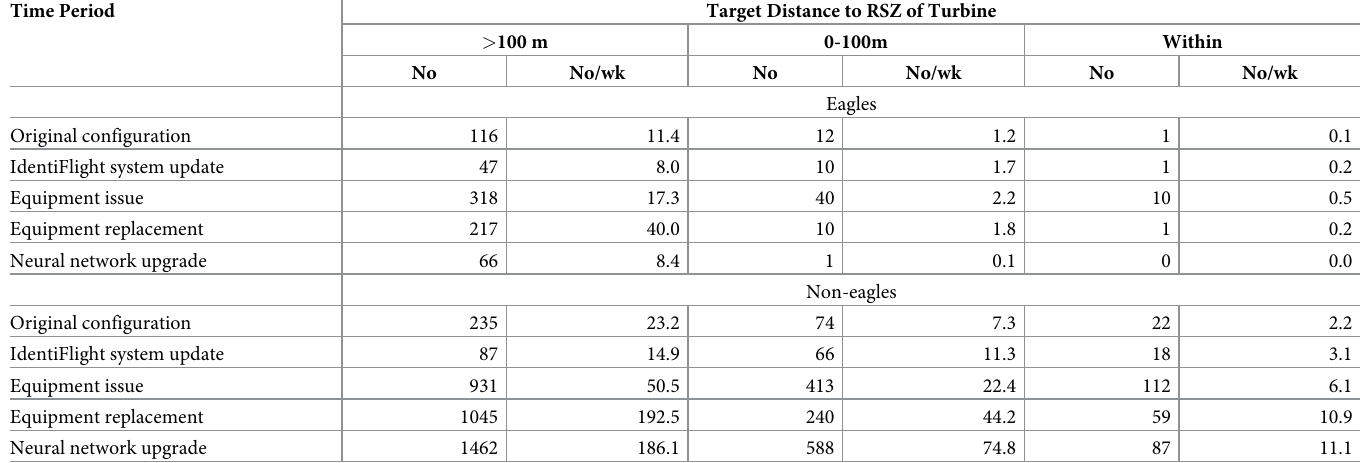
Table 3. Number and rates (no/wk) of virtual curtailments for targets that were correctly identified as eagles and incorrectly identified as non-eagles by the Identi- Flight system for each of five time periods, at the Manzana Wind Power Project, California,